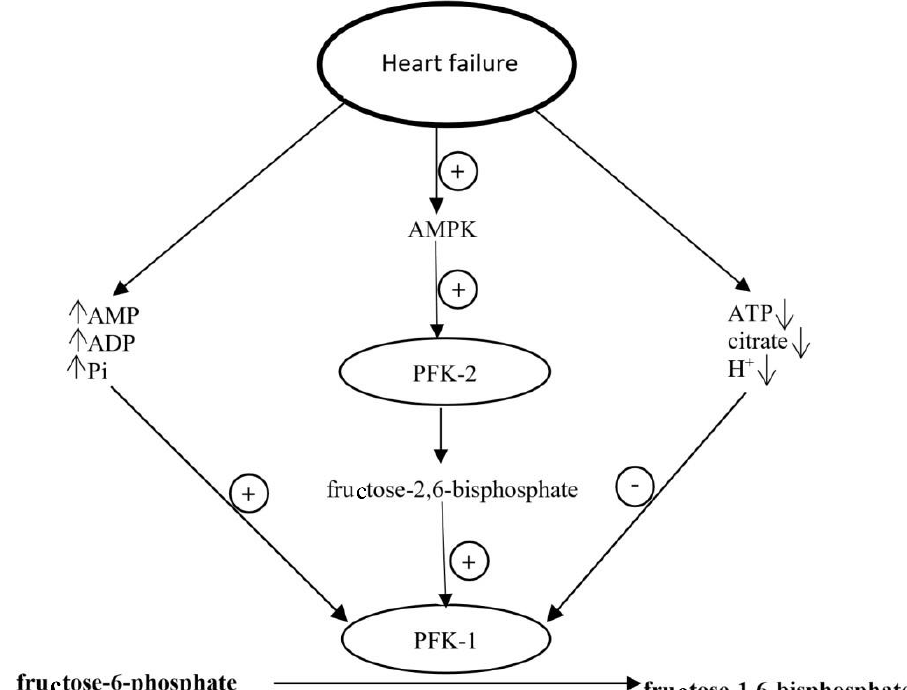
Figure 3. Regulation of PFK activity in heart failure. ADP, adenosine diphosphate; AMP, adenosine monophosphate; AMPK, AMP activated protein kinase; ATP, adenosine triphosphate; PFK-1, phosphofructokinase 1; PFK-2, phosphofructokinase 2; and Pi, inorganic phosphate. Circles with “+” and “−” represent stimulatory and inhibitory effects, respectively. ↑ and ↓ represent increase and decrease in the concentration of specific compound, respectively.